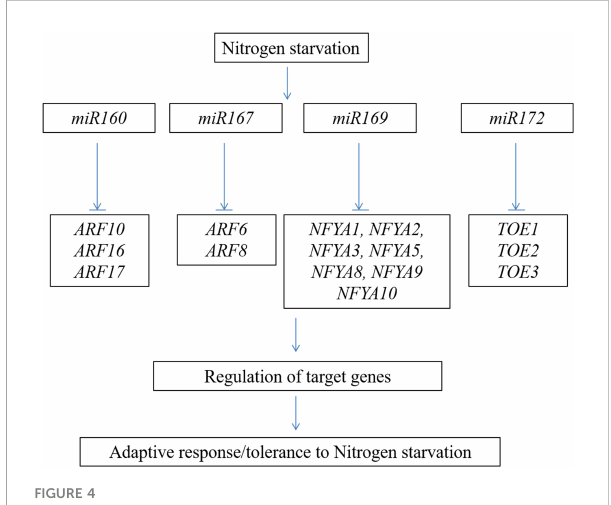
FIGURE 4 Schematic representation of important nitrogen-responsive miRNA s and their transcription factor targets involved in nitrogen starvation response.